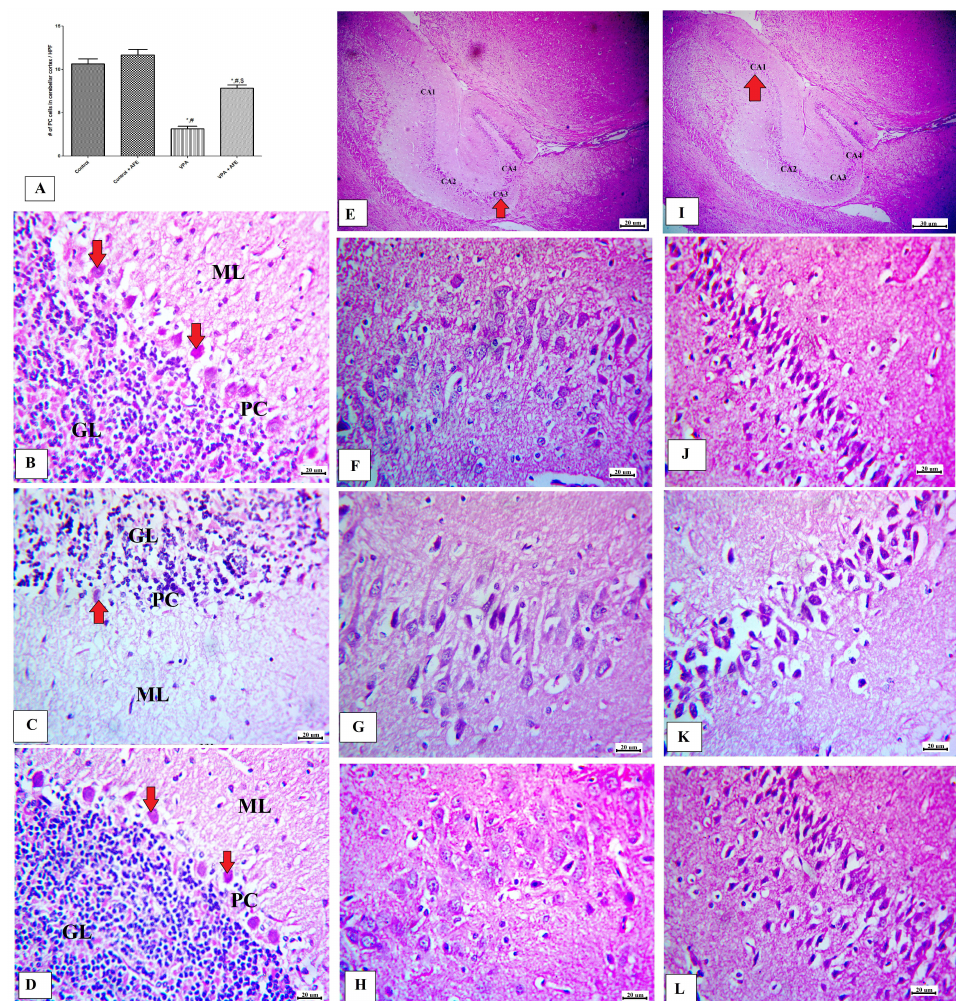
Figure 4. Effect of AFE on morphology of the cerebellum and hippocampus. ( A ) shows the mean number of Purkinje cells (PC) in the cerebellar cortex in different groups. The cerebellar cortex of the control group ( B ) consists of three layers; outer molecular layer (ML), middle Purkinje cell layer (PC), and inner granular cell layer (GL). VPA-treated group ( C ); PC appeared shrunken, disfigured with condensed chromatin (red arrows) and surrounded with vacuolated spaces which became few in number. The ML showed deeply stained pyknotic scattered basket cells and vacuolations. In the VPA + AFE group ( D ), the number of PC become high (400 × , H&E). ( E ) shows different parts of hippocampus with red arrows indicating CA3 region (40 × ). ( F – H ) show CA3 regions in brain from control, VPA, and VPA + AFE groups, respectively (400 × ). ( I ) shows different parts of hippocampus with red arrows indicating CA1 region (40 × ). ( J – L ) show CA3 regions in brain from control, VPA, and VPA + AFE groups, respectively (400 × ). The number of Purkinje cells; ( D ) were dramatically decreased in VPA-treated group; * significant vs. control group, # significant vs. control + AFE group, and $ significant vs. VPA